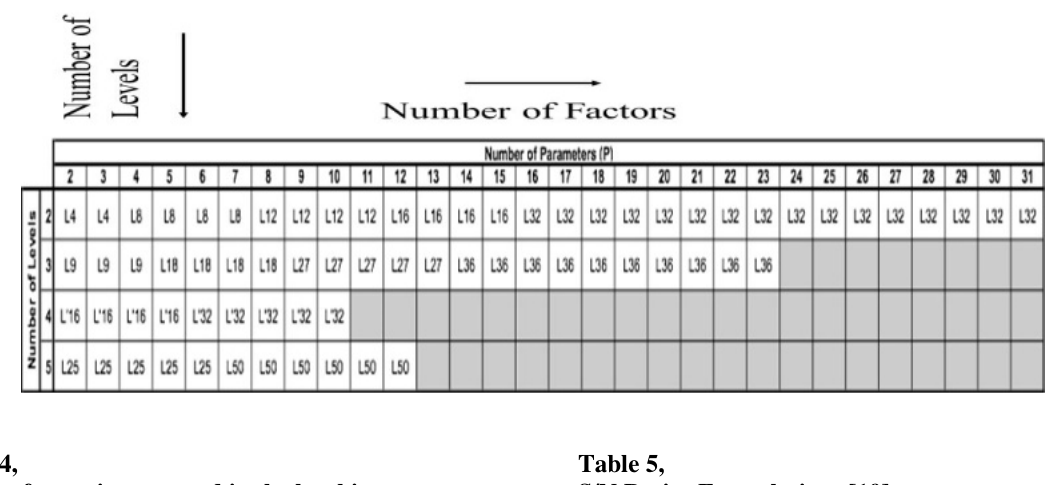
Design of experiments used in the leaching process for the catalytic converter.